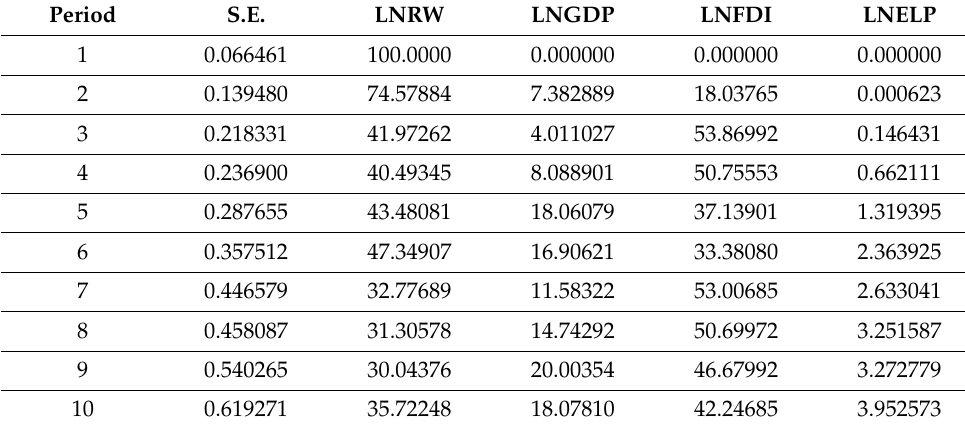
Table 8. Results of variance decomposition analysis (Kazakhstan).